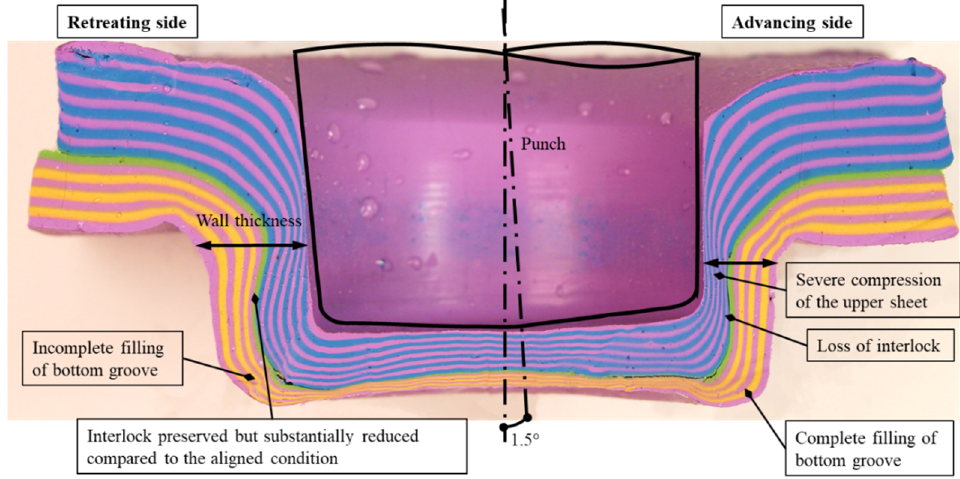
Figure 20. Description figure of 1.5° of punch misalignment (12–8 mm) with glycerin lubricant.